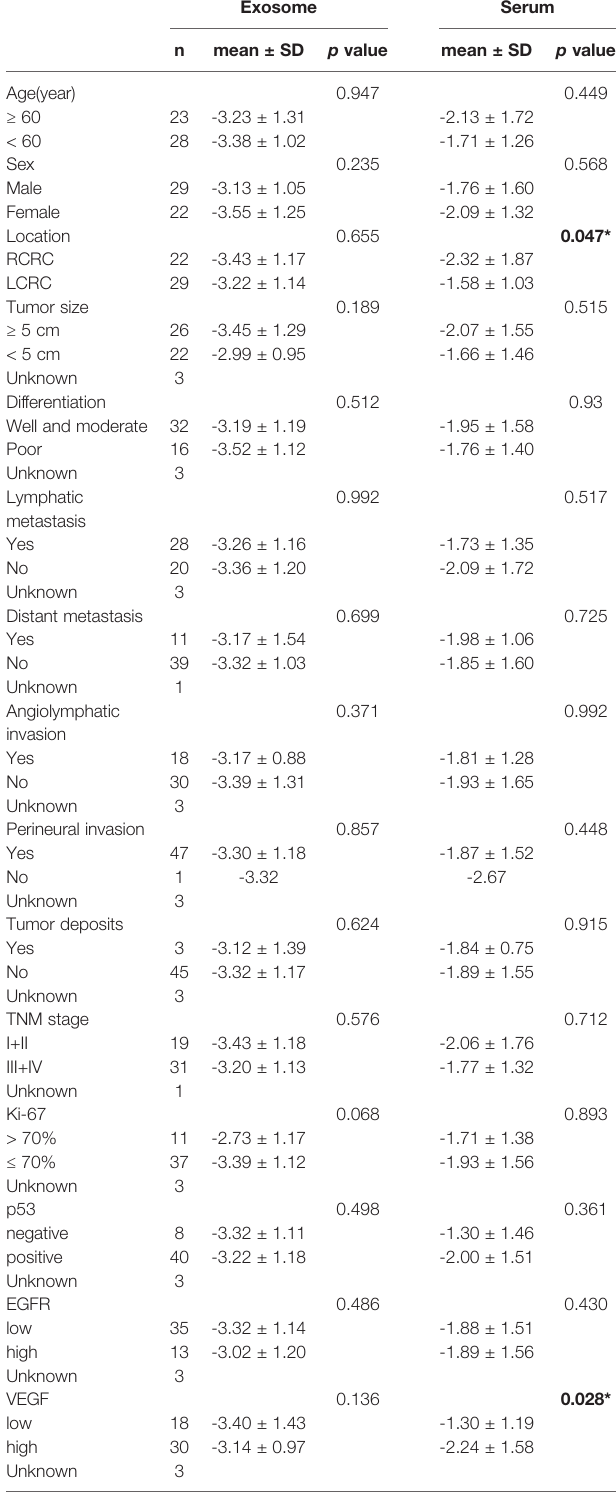
TABLE 3 | Correlation between clinicopathological factors and miR-1539 expression levels in exosome and